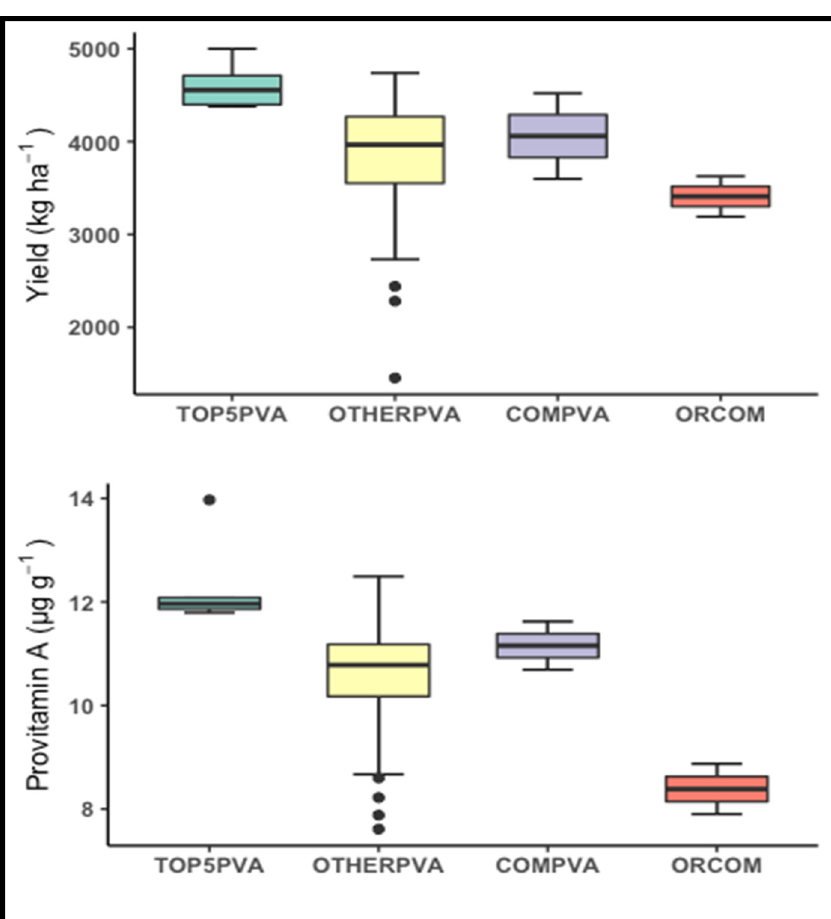
Figure 4. Box-plots of provitamin A content and grain yields of the five best provitamin A biofortified (TOP5PVA), the remaining provitamin A biofortified (OTHERPVA), commercial provitamin A biofortified (COMPVA), and an orange commercial (ORCOM) hybrids recorded across diverse environments.